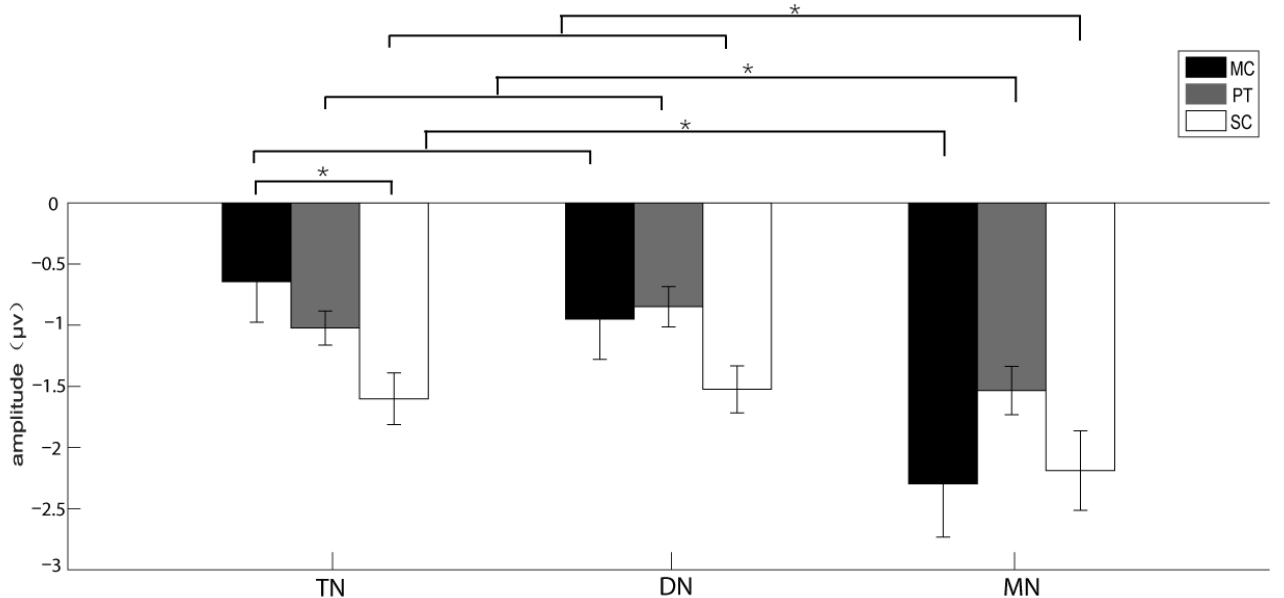
Figure 4. The amplitudes and standard errors of N1 components for the experiments recruiting reflexive attention. Each asterisk (*) indicates significant differences between different acoustic stimuli and different brain areas ( p < 0.05). MC, conspecific male advertisement call; PT, 1000 Hz pure tone; SC, screech call; TN, telencephalon; DN, diencephalon; MN, mesencephalon. Table 3. Results of ANOVA for amplitudes and latencies of N1 with respect to the three factors for the experiments recruiting reflexive attention.